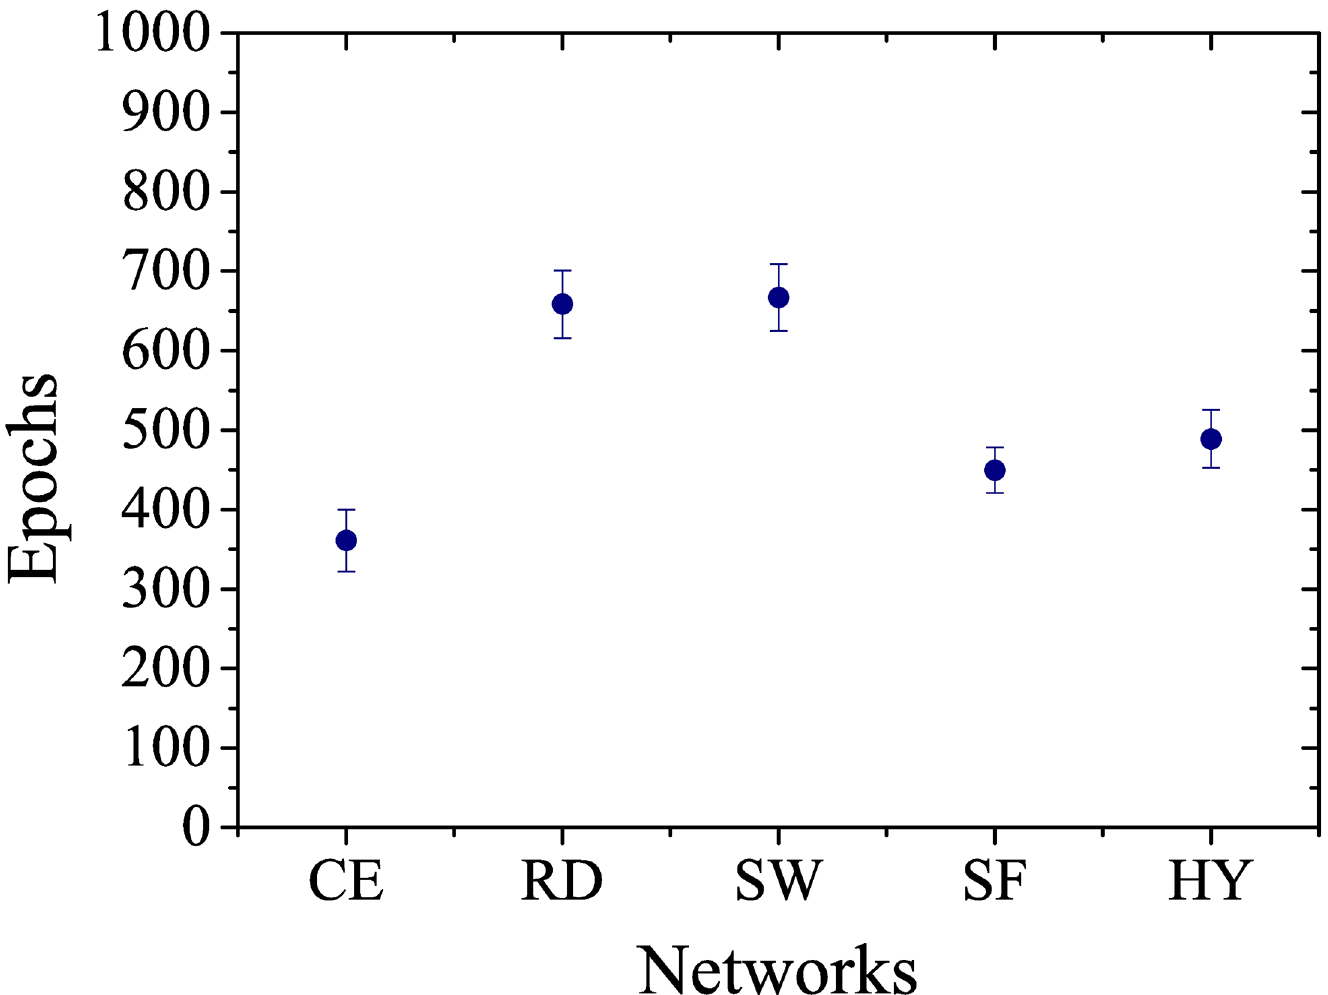
Fig 3. The number of epochs. (CE) C. elegans , (RD) random, (SW) small-world, (SF) scale-free and (HY) hybrid networks necessary to learn to interpret 100 input signals. Mean of 100